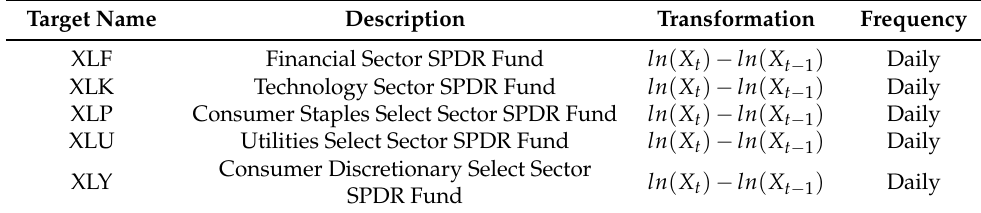
Table 8. Target variables in the forecasting experiment